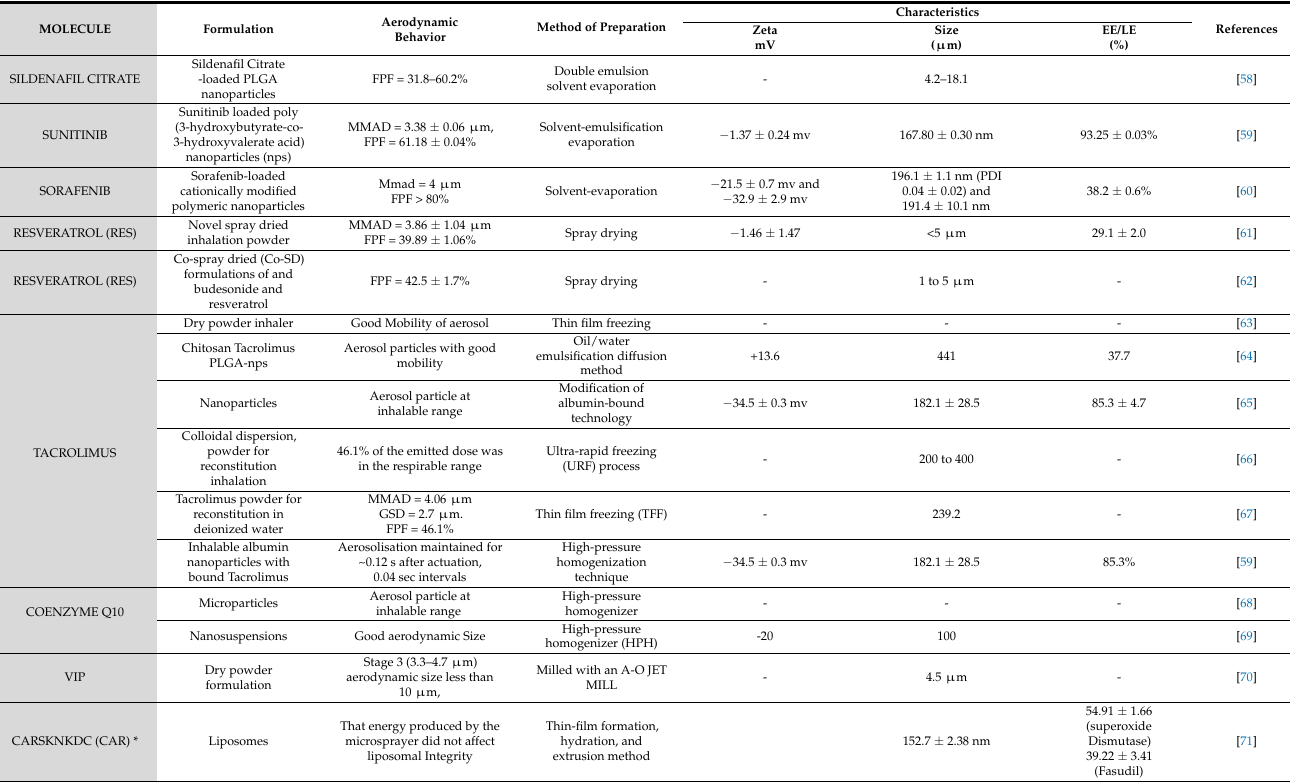
Table 1. Targeting pulmonary arterial hypertension via inhalation: pathological barriers, particle deposition, and